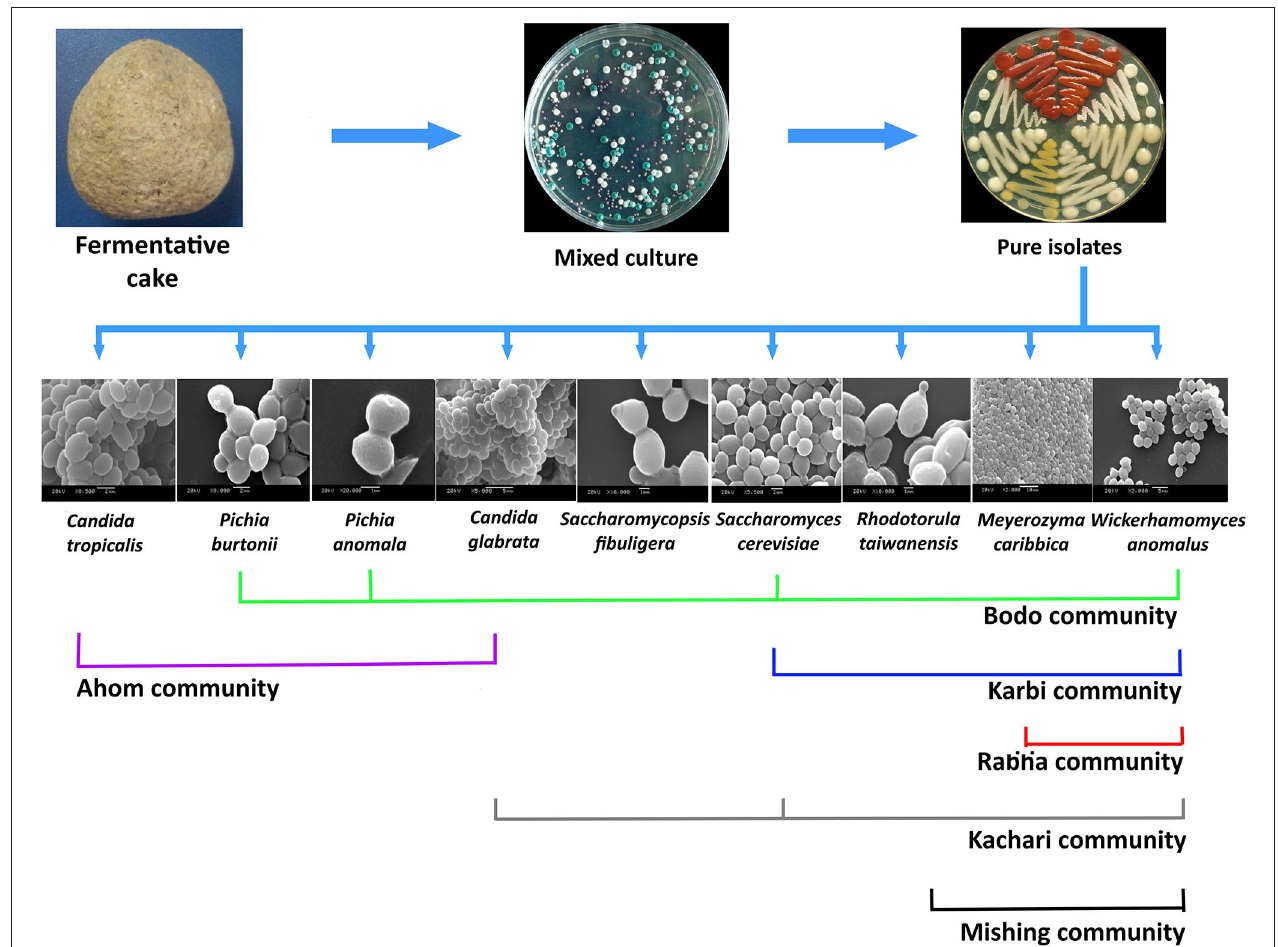
FIGURE 2 | Graphical depiction of distribution of yeasts in various starter cultures of indigenous community of Assam. The experimental data are derived from Parasar et al. (2017) and Nath et al. (2020a).